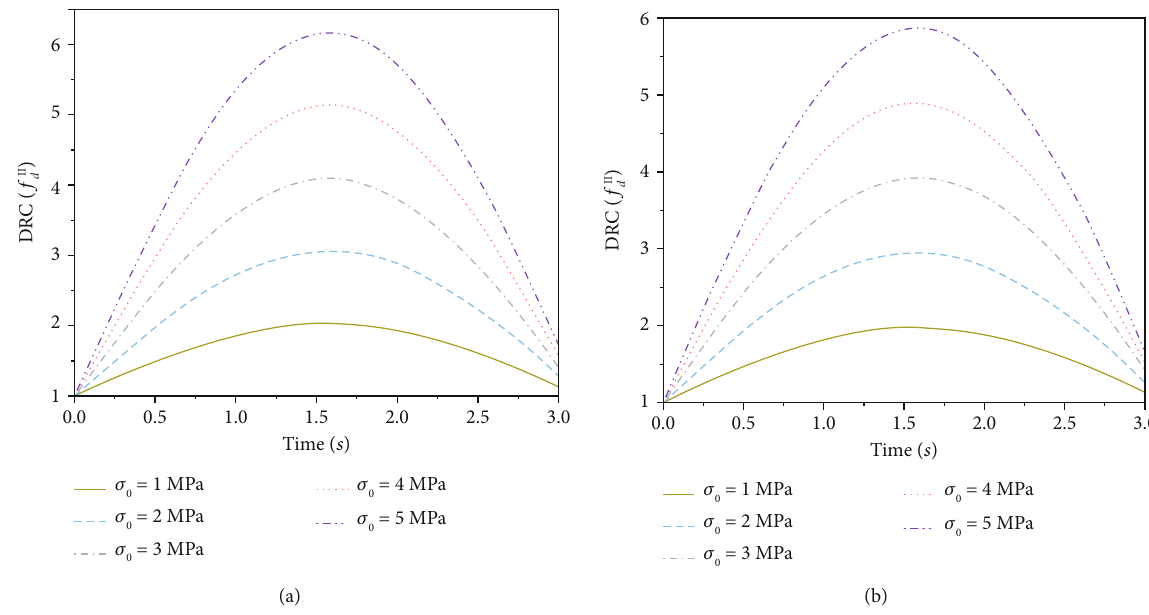
ΙΙ variations with time under di ff erent dynamic load amplitudes ( σ Figure 8: f d Table 2: Calculation results of f